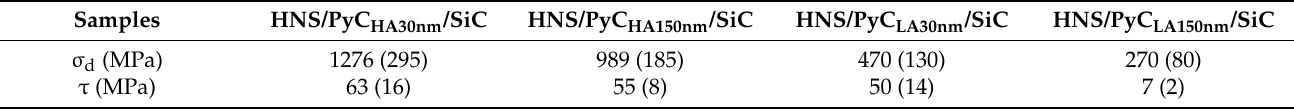
Figure 5. Typical push-out test curve of HNS/PyC HA30nm /SiC, HNS/PyC HA150nm /SiC, HNS/ PyC LA30nm /SiC and HNS/PyC LA150nm /SiC. Table 5. Results of push-out tests on HNS reinforced composites. () standard